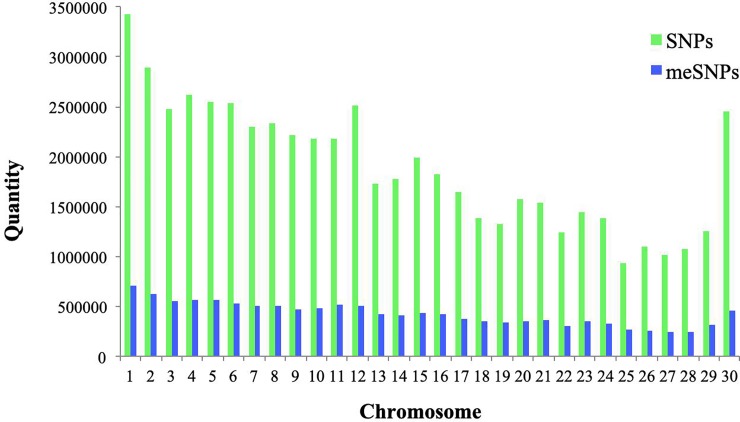
SNPs versus meSNPs.Number of meSNPs identified in comparison to the total number of SNPs annotated in Run5 of the 1000 Bull Genomes Project by chromosome.